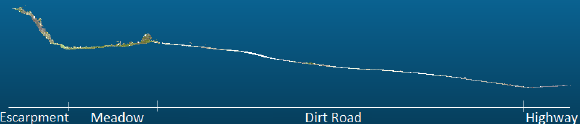
Figure 11. Up profile distribution.